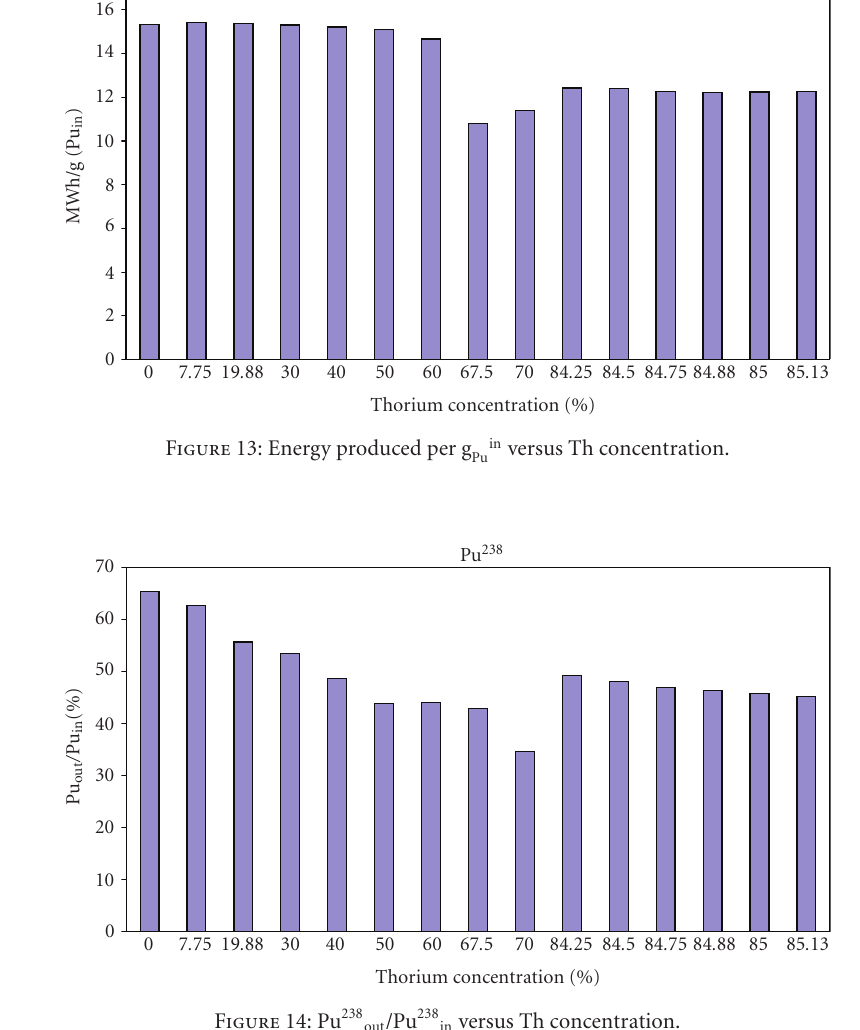
Figure 14: Pu 238 out /Pu 238 in versus Th